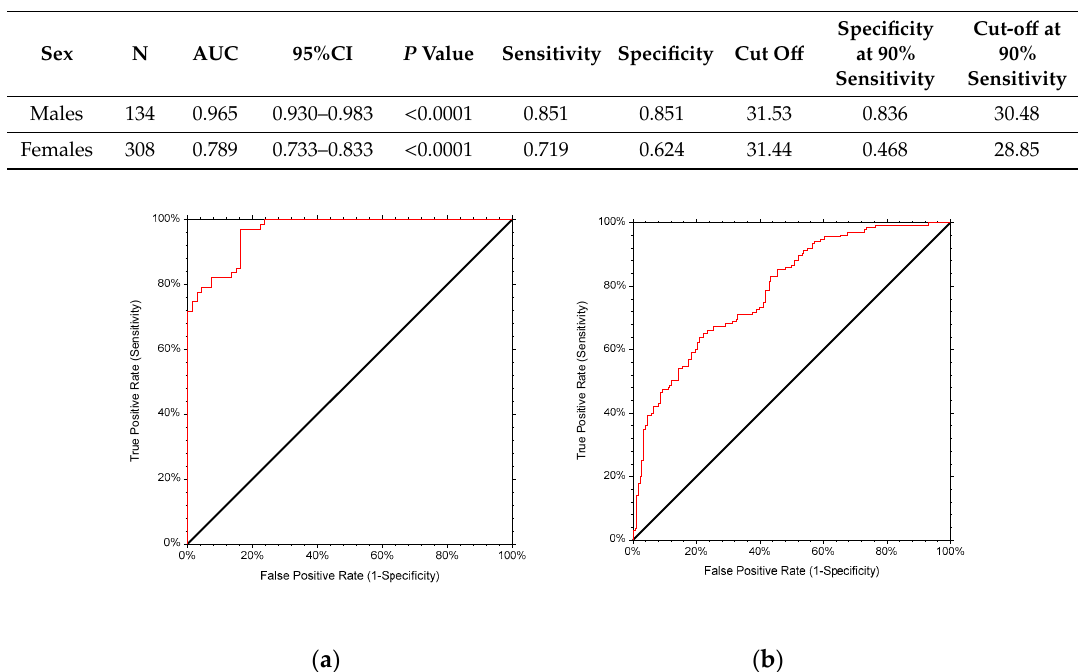
Figure 2. ( a ) ROC for the BMI cut-off point to detect obesity based on BF% as the gold standard in males; ( b ) ROC for the BMI cut-off point to detect obesity based on BF% as the gold standard in females.